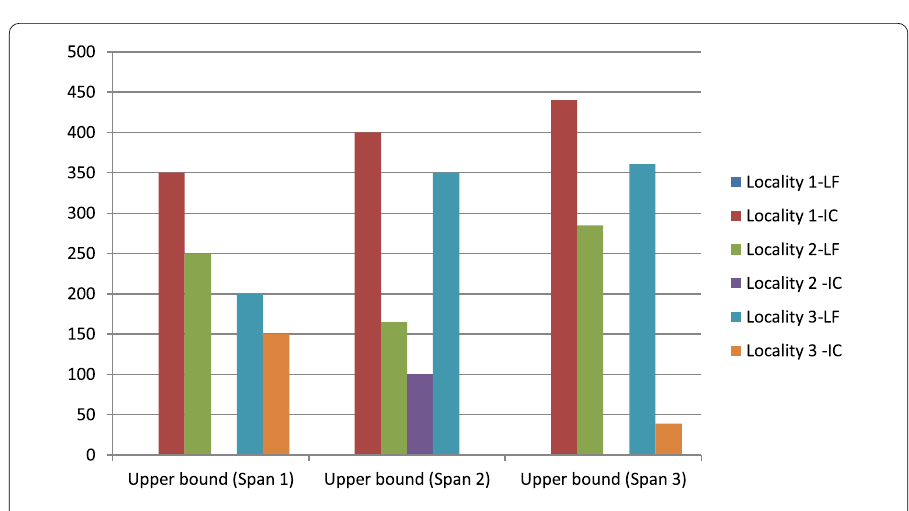
Figure 8 Amount of waste allocation to achieve f +